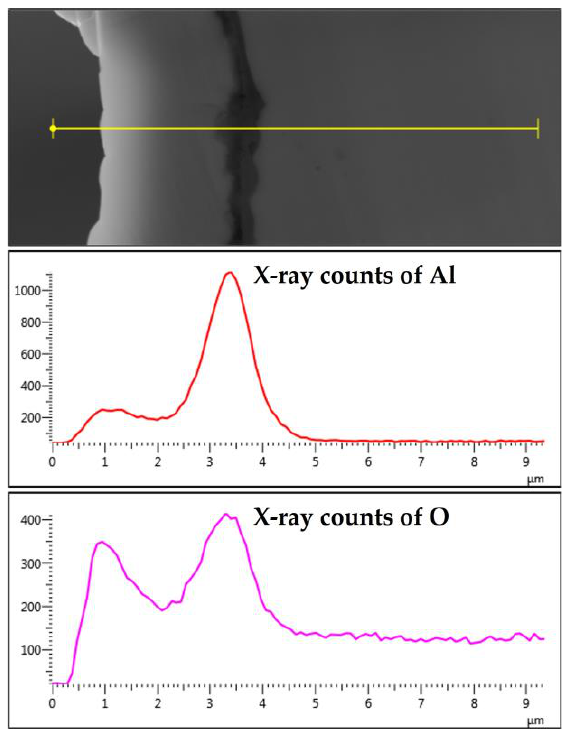
Figure 18. The characteristic X-ray counts of Al and O along a line starting from the outer edge of the oxide-scale layer into a few microns of the 12 μ m fiber after 18 MSHT cycles.